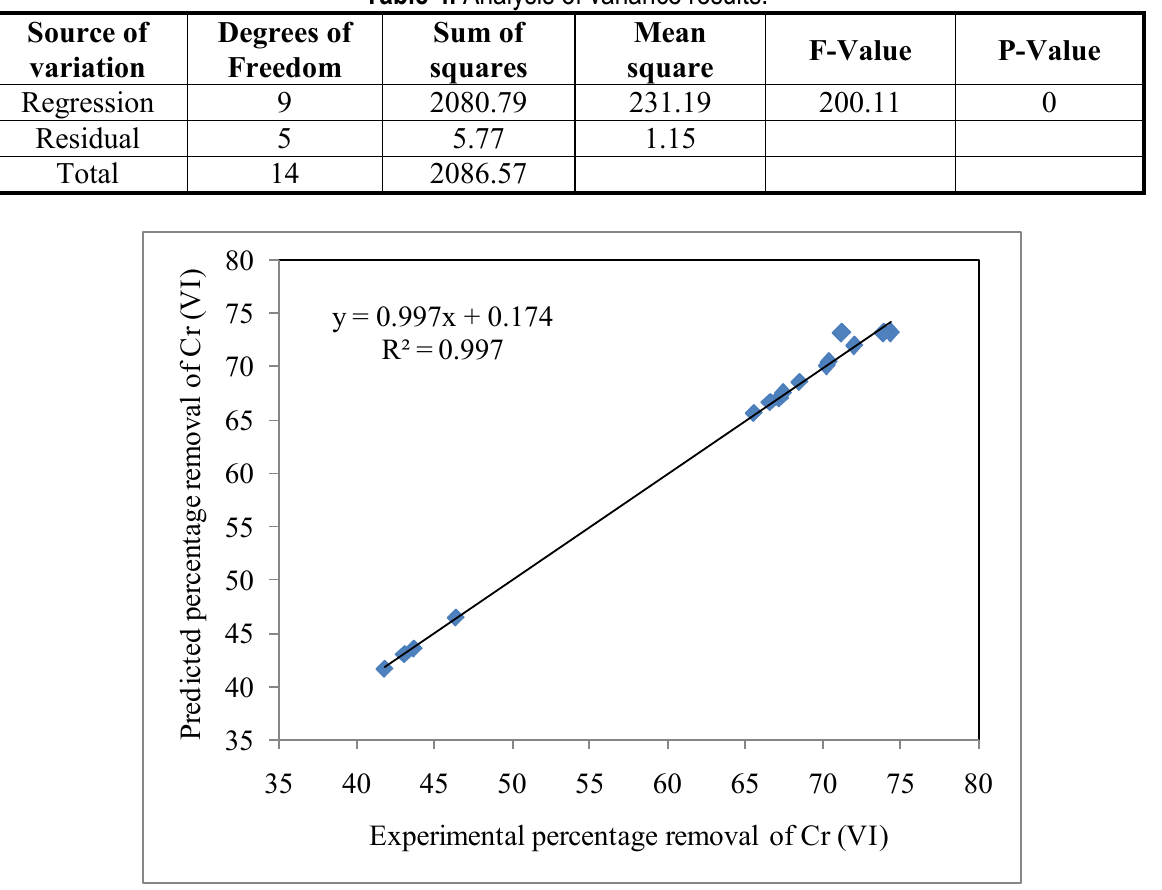
Table 4. Analysis of variance results.